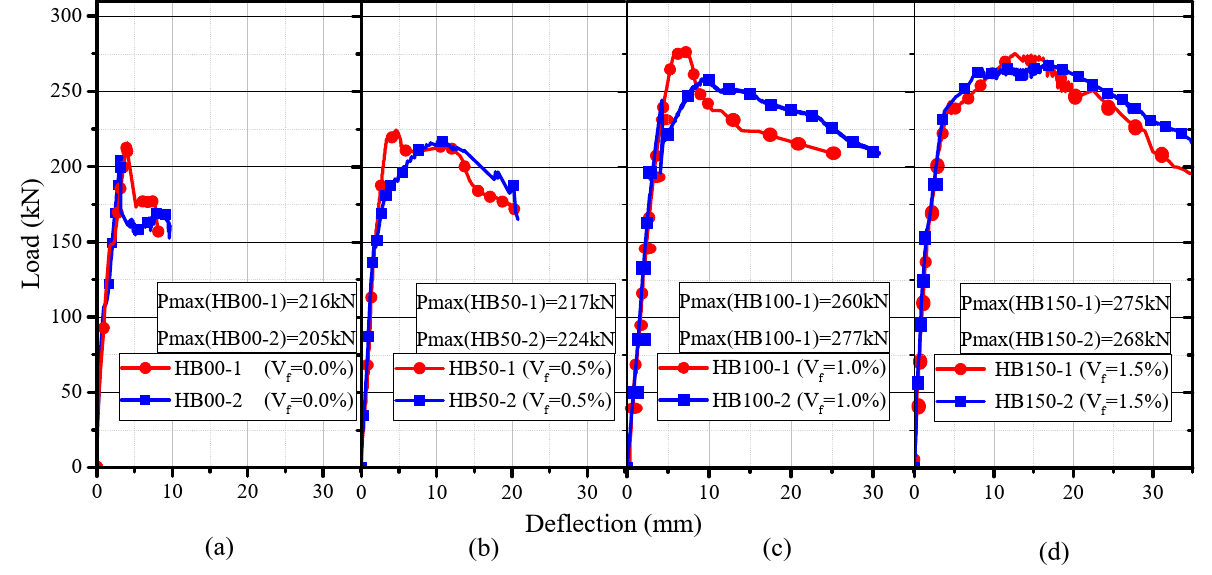
Figure 7. Load–deflection responses of HFRPC: ( a ) HB00; ( b ) HB50; ( c ) HB100; ( d ) HB150 beams. Table 4. Summary of experimental results on beams.